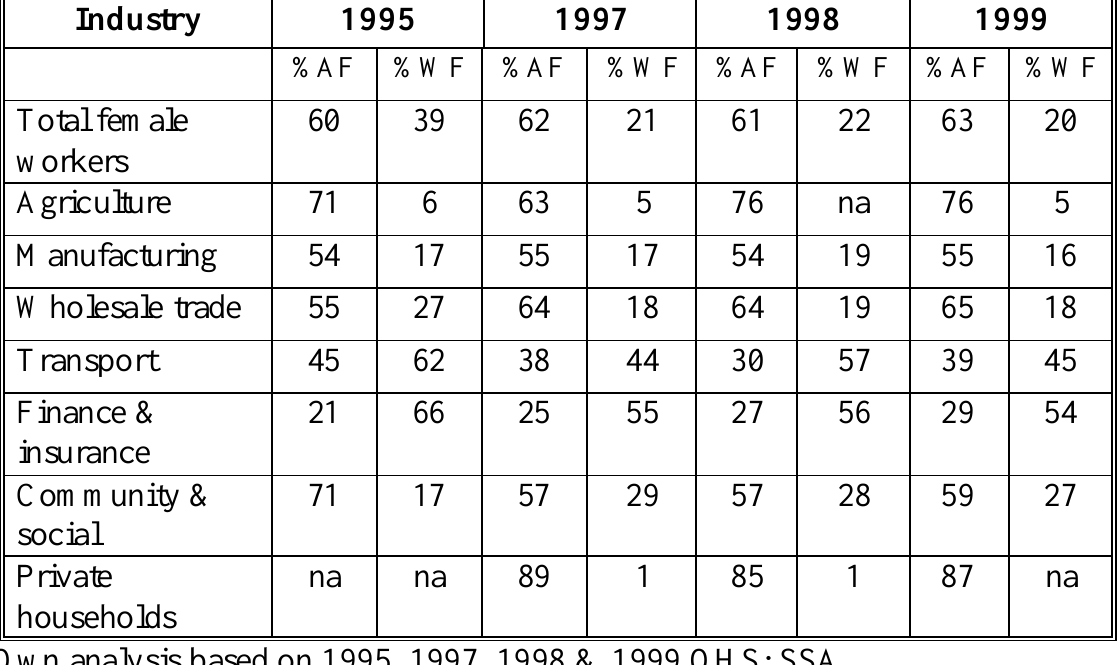
Distribution of African and White female workers per industry